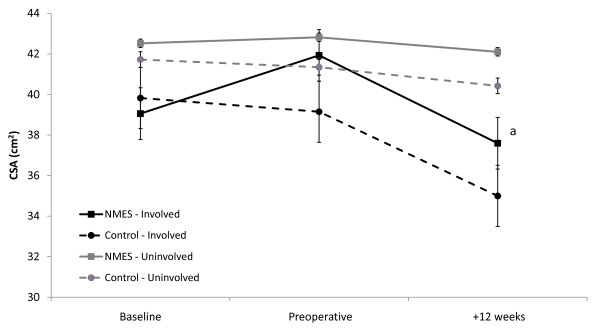
Quadriceps Femoris Muscle Cross-sectional Area. ap < 0.05 vs. Preoperative; Error Bars represent Standard Error